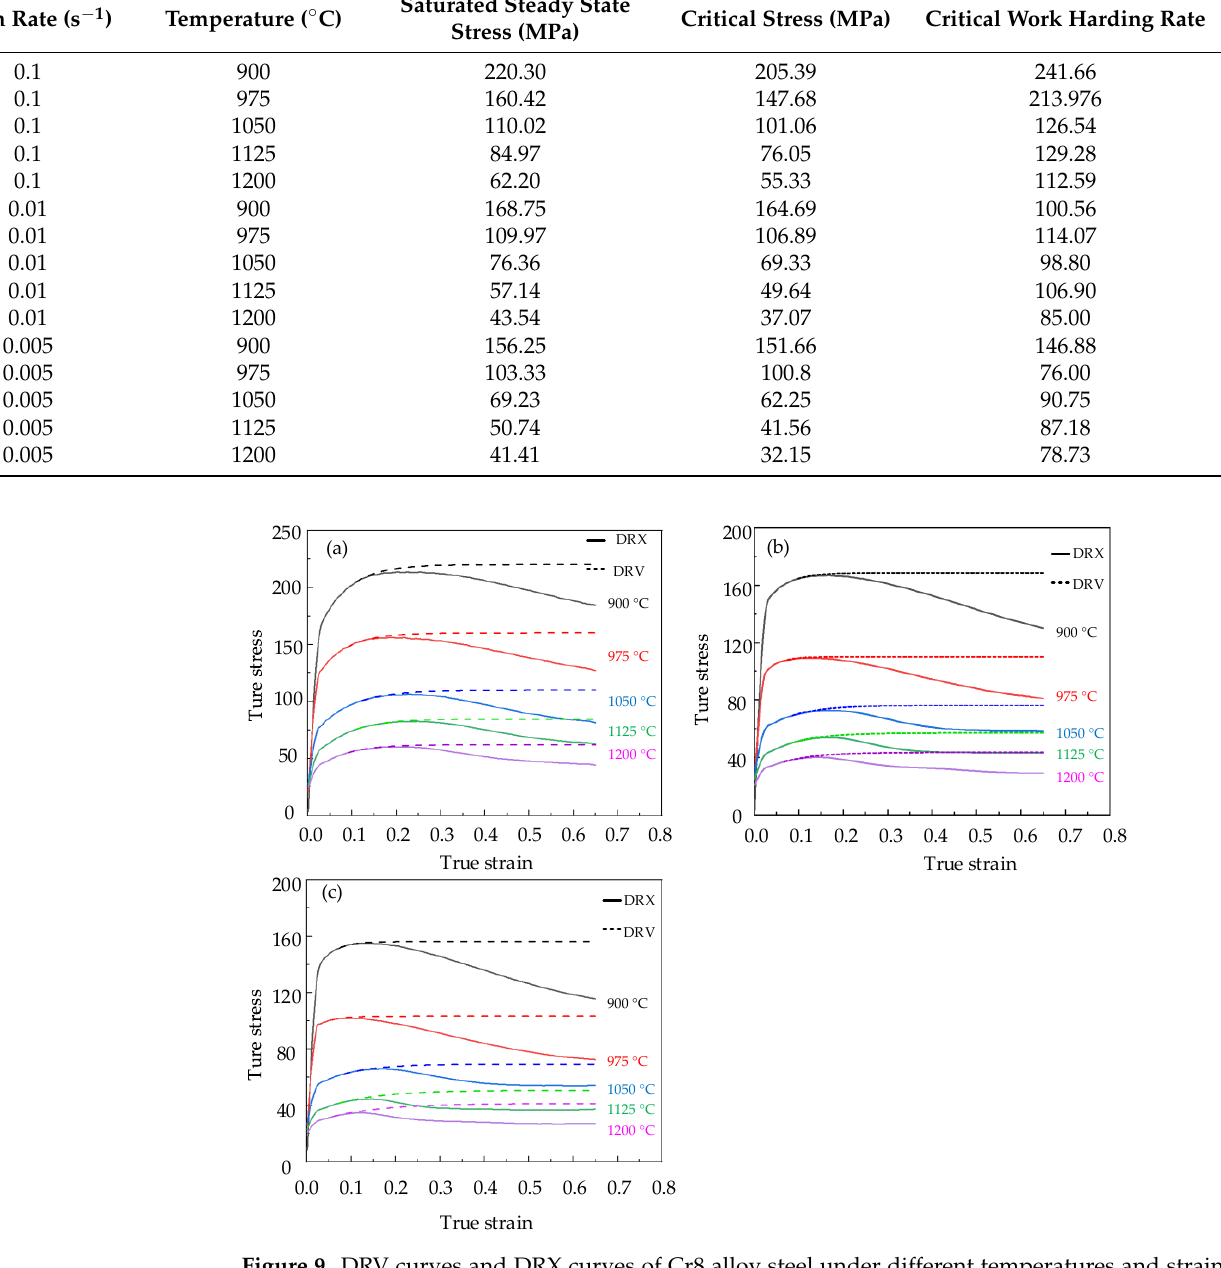
Figure 9. DRV curves and DRX curves of Cr8 alloy steel under different temperatures and strain rates: ( a ) = 0.1 s −1 ; ( b ) = 0.01 s −1 ; ( c ) = 0.005 s −1 . Table 5. Characteristic strain ε 0.5 of Cr8 alloy steel under different